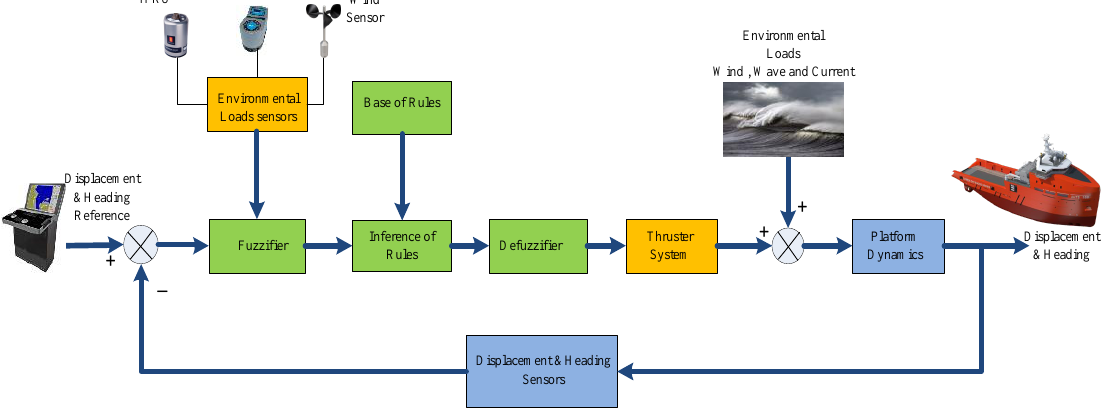
Figure 8. Blocks of a DP fuzzy controller .